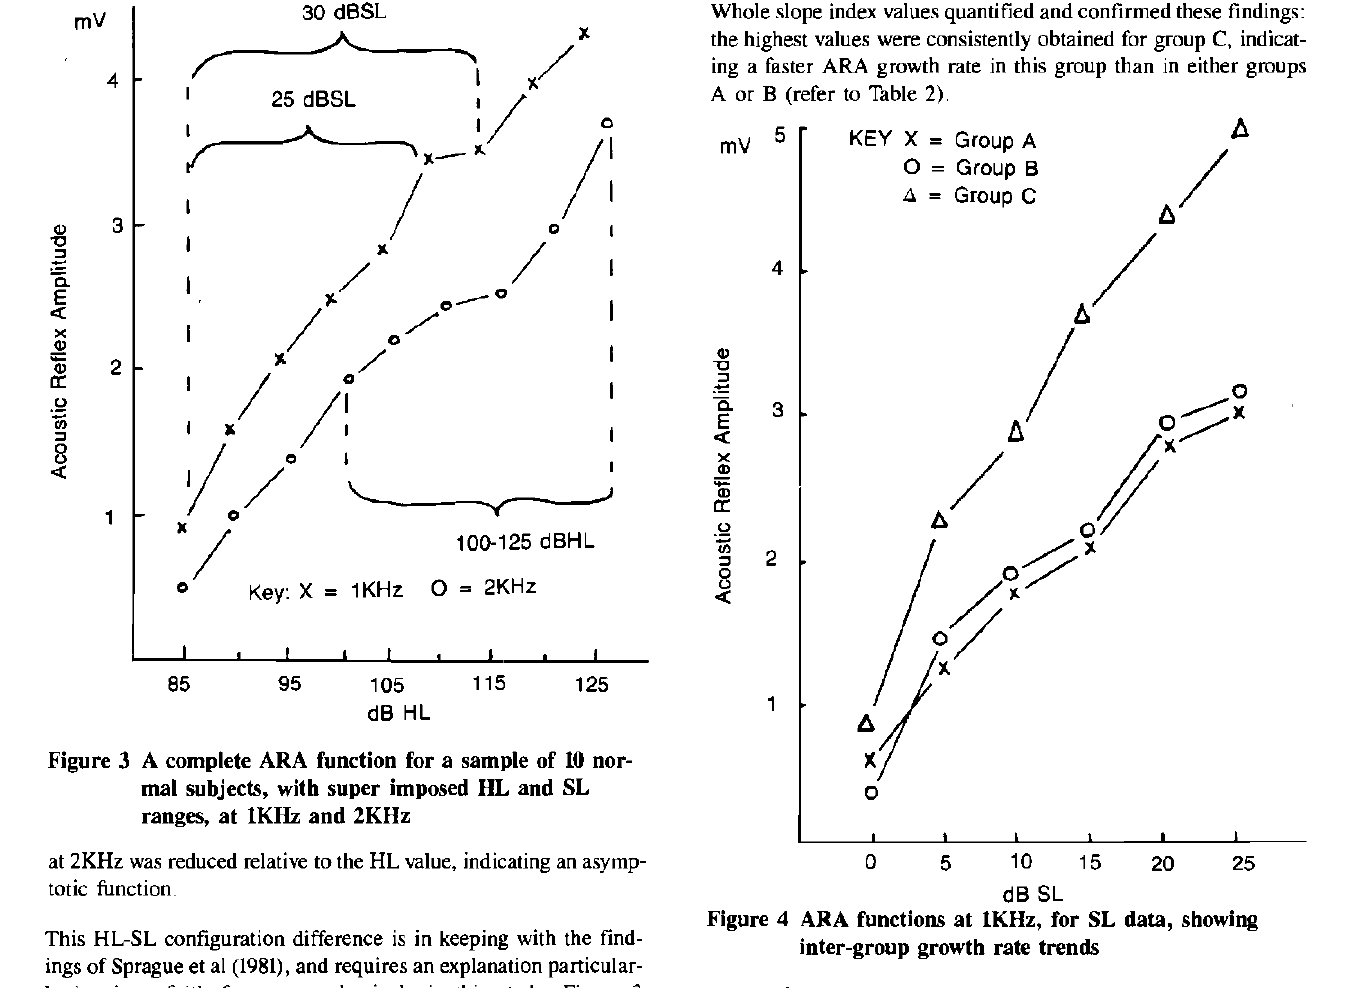
Figure 4 ARA functions at IKHz, for SL data, showing inter-group growth rate trends mV 5